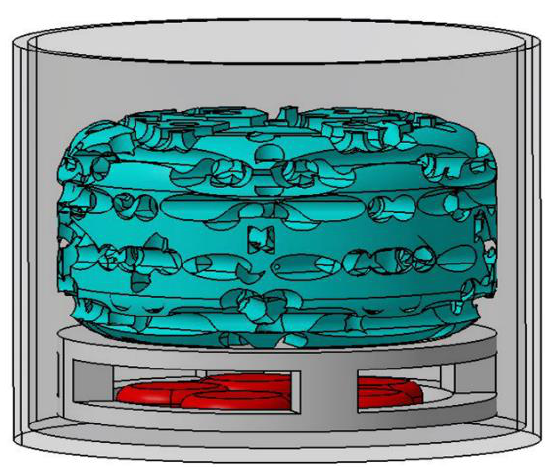
Figure 6. Designed scaffold and muscle/fascia tissue fragments co-culture system : circular plastic bracket designed to support the scaffold and avoid direct contact with the underlying muscle/fascia fragments; co-culture system in 12-well plates.